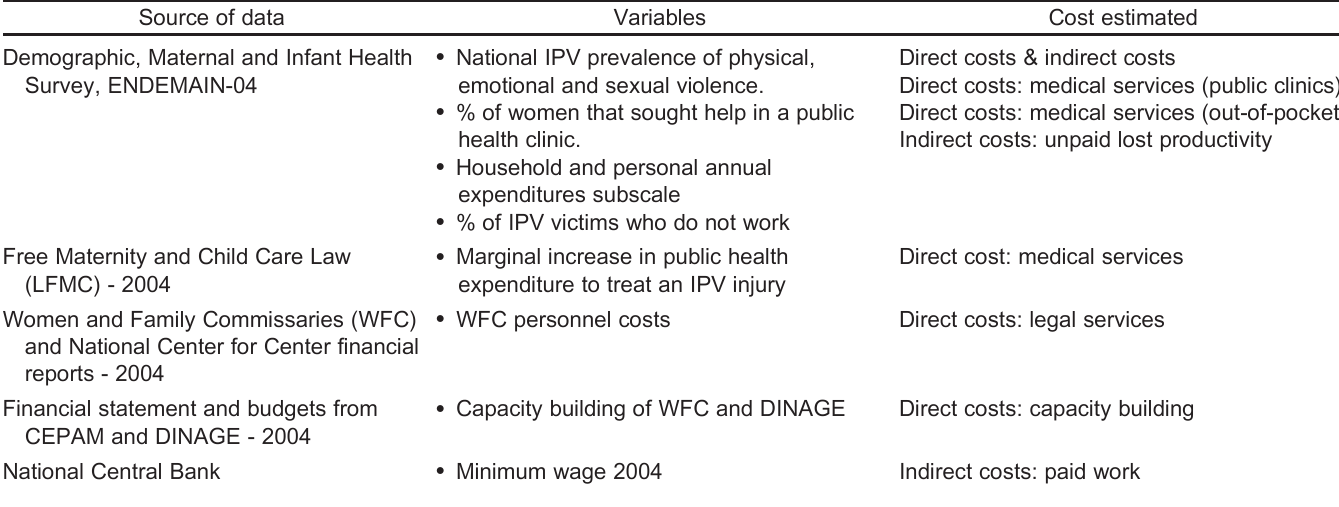
Table 1. Data sources used in the estimation of the economic burden of intimate partner violence (IPV) for Ecuador.